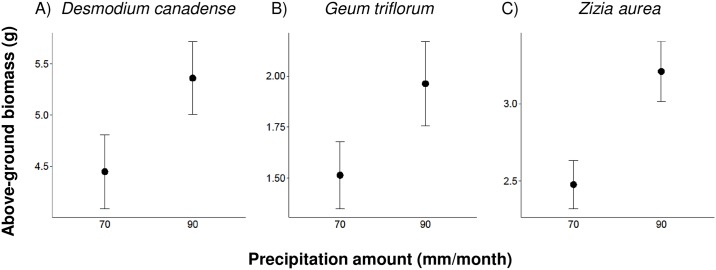
Above-ground biomass in response to precipitation amount and frequency.The effect of precipitation amount on above-ground biomass for three eudicot species. There was a significant effect of precipitation amount on: (A) Desmodium canadense, (B) Geum triflorum, and (C) Zizia aurea, whereas the effects of frequency and amount × frequency interaction were non-significant (see Table 1). Points show least-squares mean values and whiskers denote ± 1 SE around the mean.